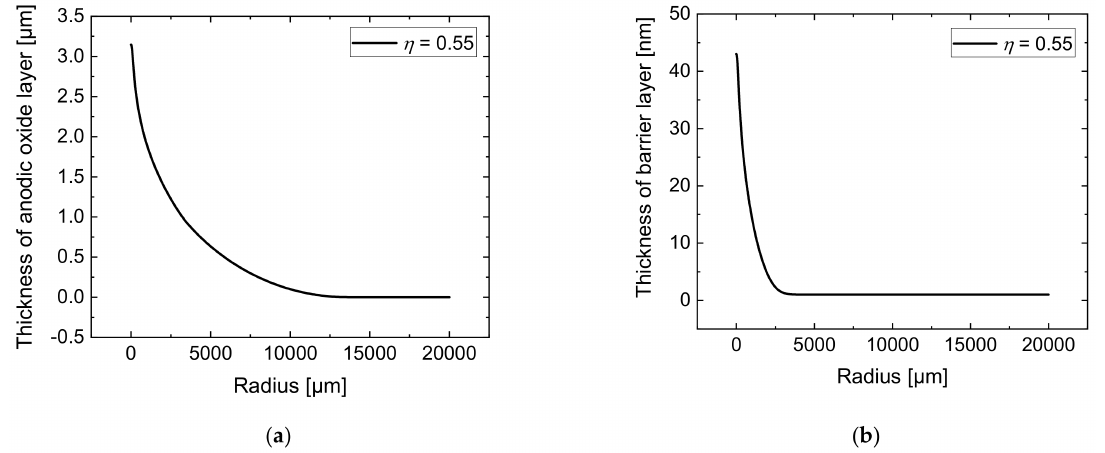
Figure 6. Simulated total anodic oxide thickness on the workpiece surface ( a ) and simulated barrier layer thickness on the anode surface ( b )—each after 10 min with a current efficiency of η = 0.55 in jet-based anodization.